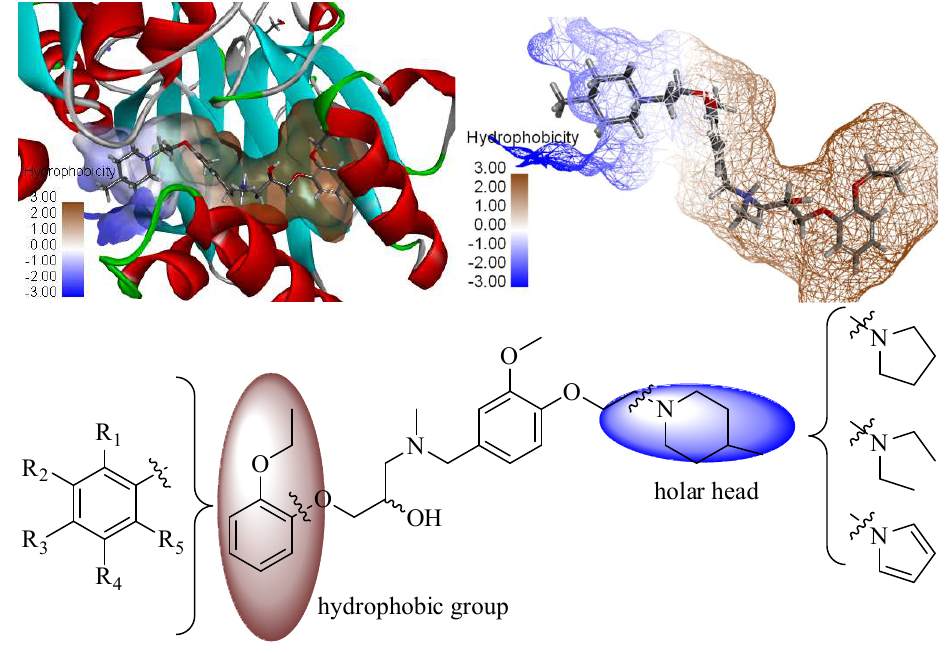
Figure 1. The structure of SAMS10 and the docking of SAMS10 ( SAMS10 , this racemate was used for molecular docking, the R configuration of SAMS10 was used for the analysis) with a SphK1 crystal structure ( 3vzb ).